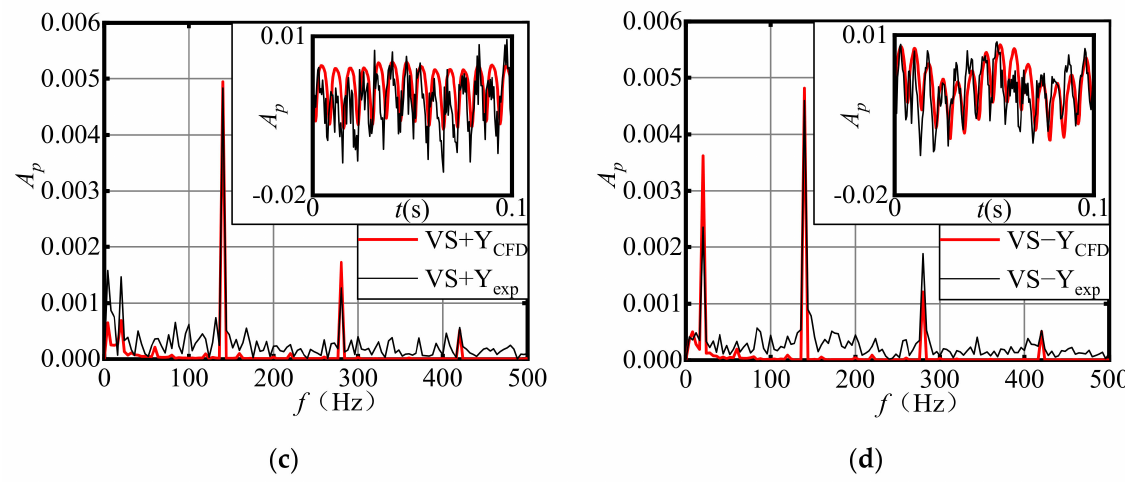
Figure 10. Comparison between CFD and experimental pressure pulsation at ϕ d . ( a ) VS + X; ( b ) VS − X; ( c ) VS + Y; ( d ) VS − Y.